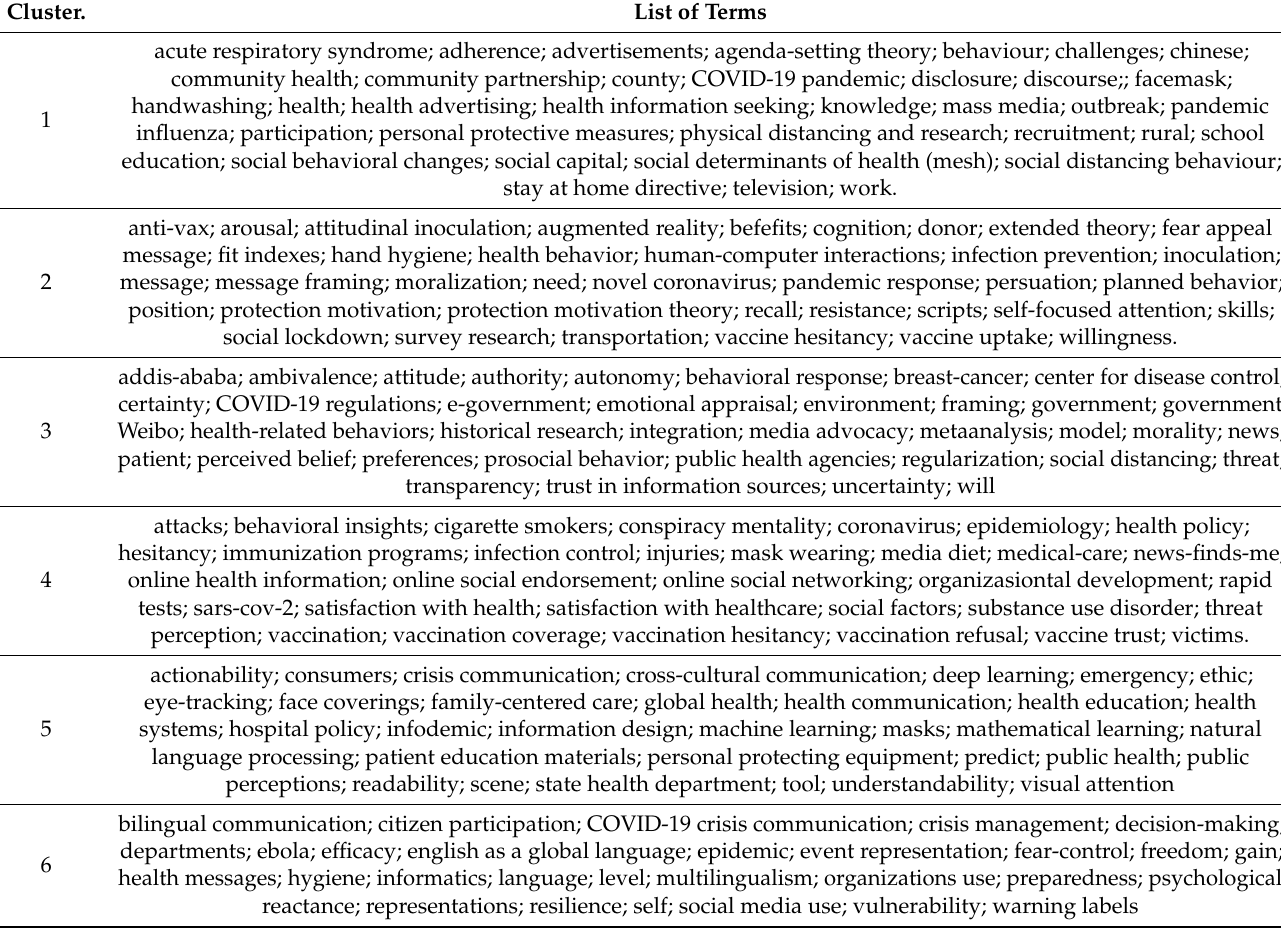
Table A1. Cluster analysis. List of